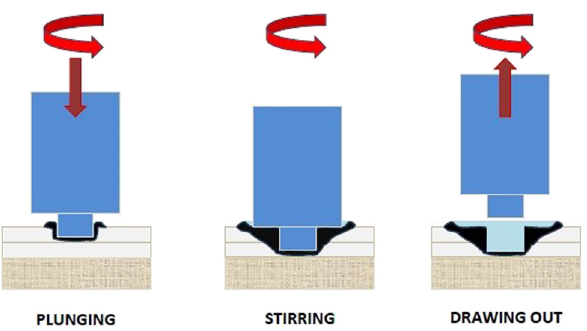
Figure 2: Friction stir spot welding processes.